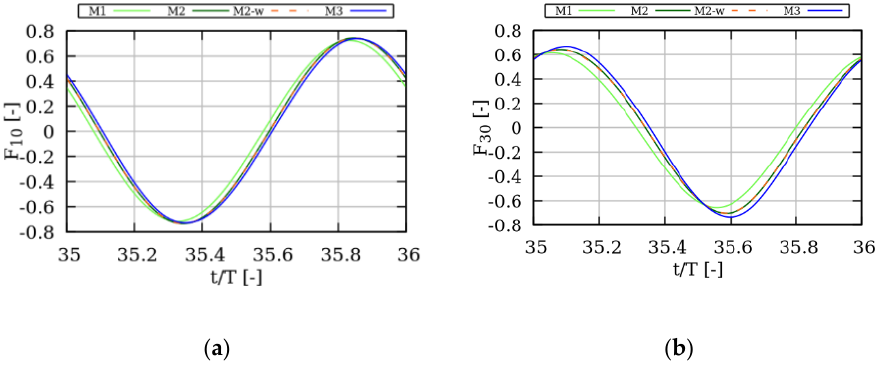
Figure 4. Grid Independency study. Forces acting on Configuration 2 during the 35th wave period. The wave excitation frequency is ω = 0.80 rad/s; ( a ) horizontal excitation force; ( b ) vertical excitation force.